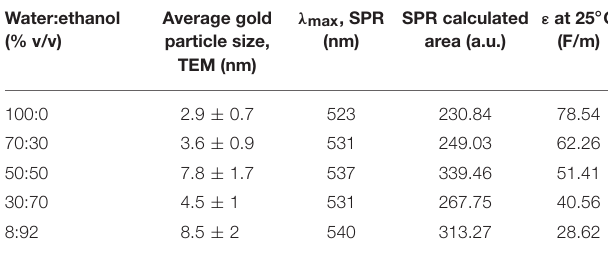
max , SPR calculated area, dielectric constant of the used medium.